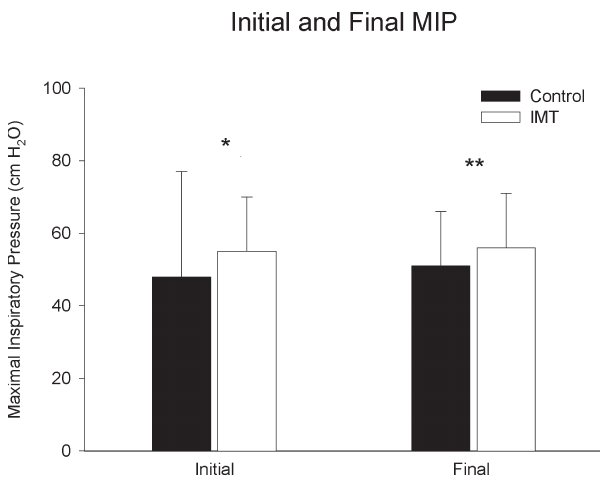
Figure 2 - Initial and final maximal inspiratory pressure. The left grouped bars represent initial maximal inspiratory pressure (24 hours after intubation). The right grouped bars represent final maximal inspiratory pressure (immediately before extubation) * P = .30 for the difference between control and inspiratory muscle training O, respectively) (IMT) group (-48 ± -29 and -51 ± -15 cm H 2 ** P = .85 for the difference between control and inspiratory muscle training (IMT) group (-55 ± -15 and -56 ± -15 cm H O, 2